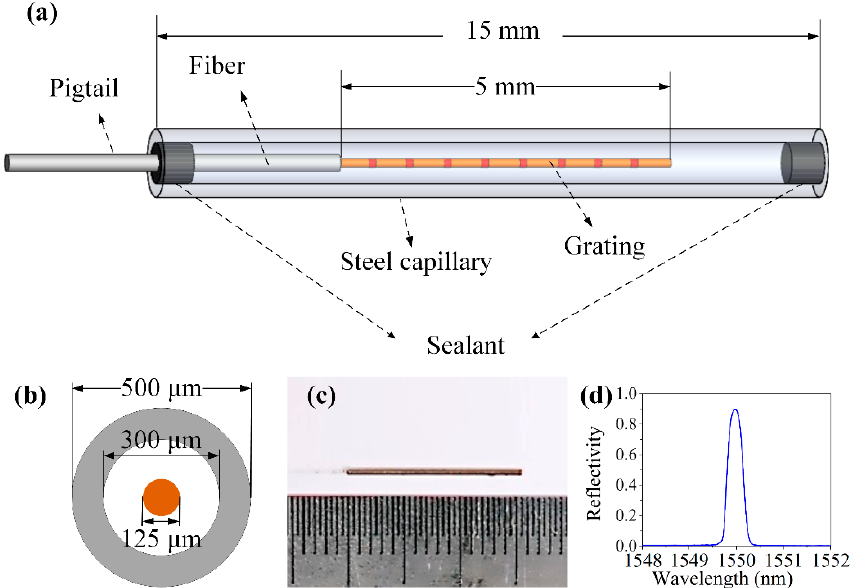
Figure 1. ( a ) Schematic diagram, ( b ) cross section, ( c ) photo of the encapsulated fiber Bragg grating (EFBG) sensor, and ( d ) typical reflection spectrum.